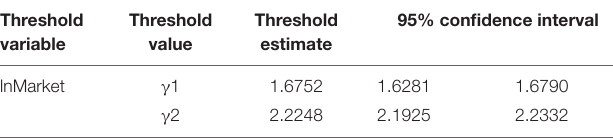
TABLE 7 | Threshold estimation and confidence intervals.